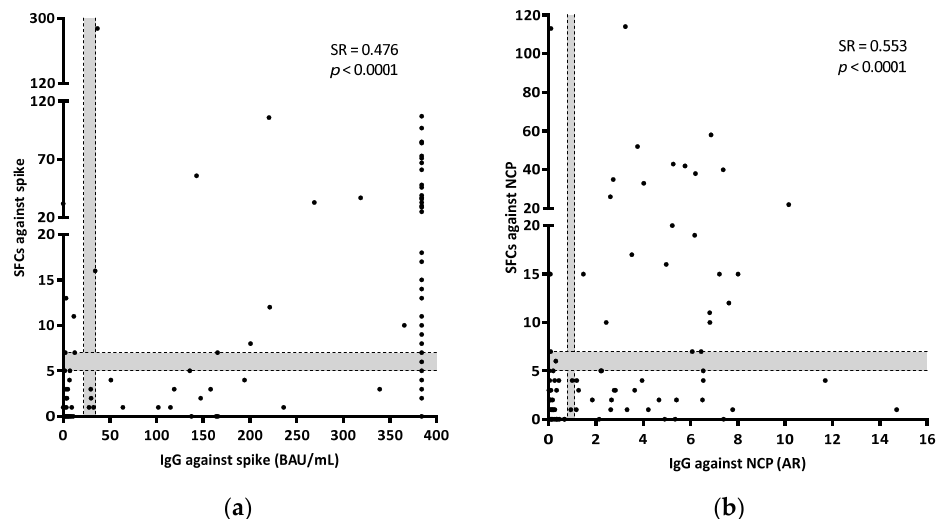
Figure 3. Correlations between the IFN- γ T-cell (SFCs) and IgG responses against spike ( a ) and NCP ( b ). AR refers to Absorbance Ratio (sample Abs/calibrator Abs). BAU refers to Binding Antibody Units. Grey areas show borderline results. Correlations were calculated using the two-tailed non-parametric Spearman test. In Figure 3a, results out of the calibration curve (equal or over 384 BAU/mL) were excluded from the Spearman test.